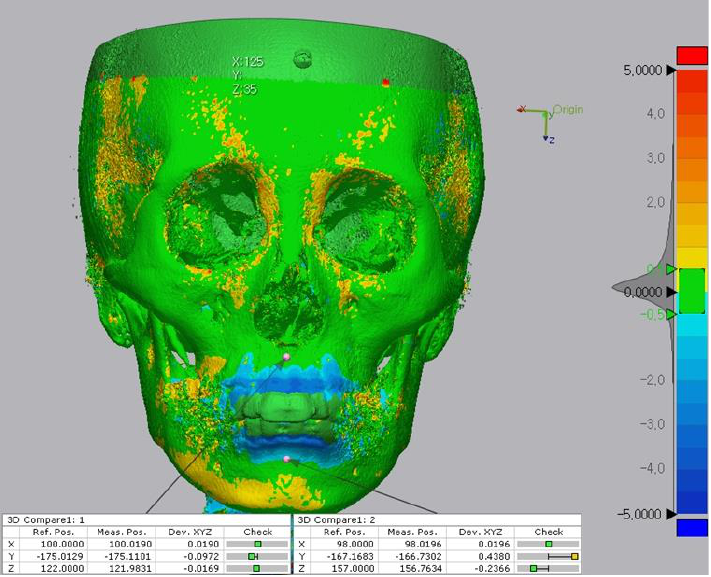
Figure 5. Comparison of reference points (pre) and measure points (post) located on the bone surface after the superposition. The 3D discrepancies were analyzed on the basis of a color-coded map. The color scale ranges from − 5 mm (blue), indicating subtractive changes to +5 mm (red), indicating additive changes. Green indicates no difference.